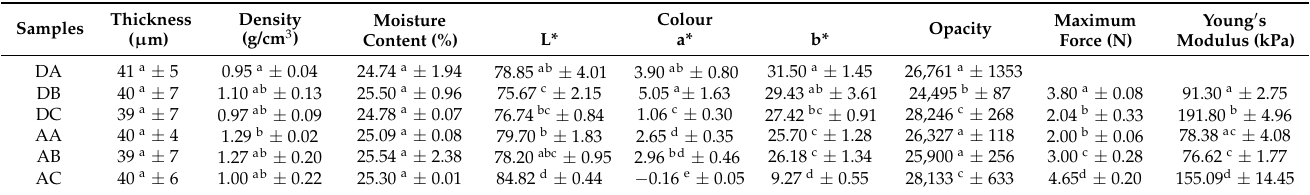
Table 3. Physicochemical properties of films based on dittany (D) or anise (A) and pectins (A, B, C). Pectins A and B were extracted from orange peels using MAE (620 W, 1:25 w/v , 3 min) and UMAE (50/850 W, 1:20 w/v , 30/3 min), respectively. Pectin C was a commercial